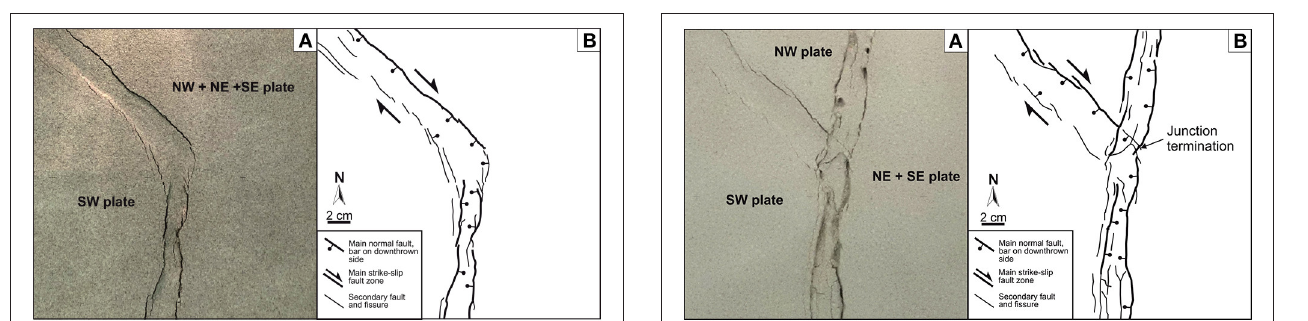
FIGURE 8 | (A) Photo of the experiment 1, made with only the SW plate moving westward, and the other three plates fixed. (B) Sketch of the photo with indication of the main and secondary faults and extensional fractures. Note the development of the transform fault (HFF) with a right-lateral transtensional kinematics and of the southern GF with normal motions. This one-plate kinematics does not account for the other structures found in the field.